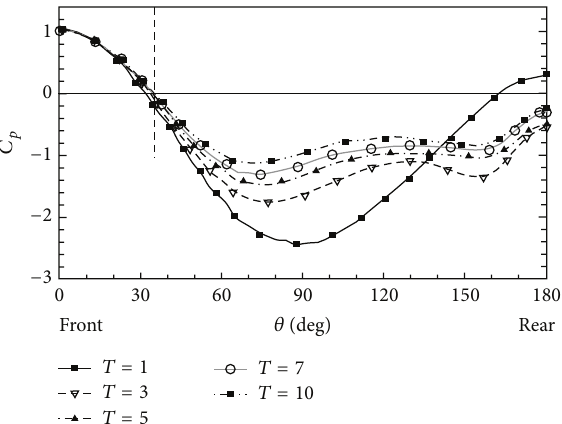
Figure 6: Surface pressure distribution at several instants for Re = 550